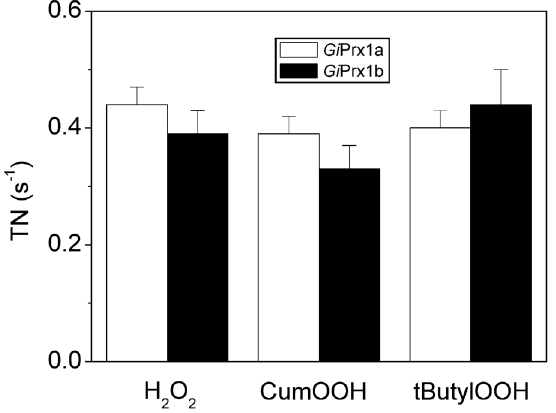
Figure 2. Alkyl-hydroperoxide reductase activity of Gi Prxs. Turnover number (TN) measured in the presence of 200 m M NADPH, 4 to 12 U mL 2 1 E. coli TrxR, 10 m M E. coli Trx and 100 m M CumOOH or 100 m M t-butylOOH, as compared to the activity measured with 100 m M H 2 O 2 under otherwise identical conditions (mean 6 1 SEM, n $ 8 for Gi Prx1a and n $ 6 for delta Gi Prx1b).